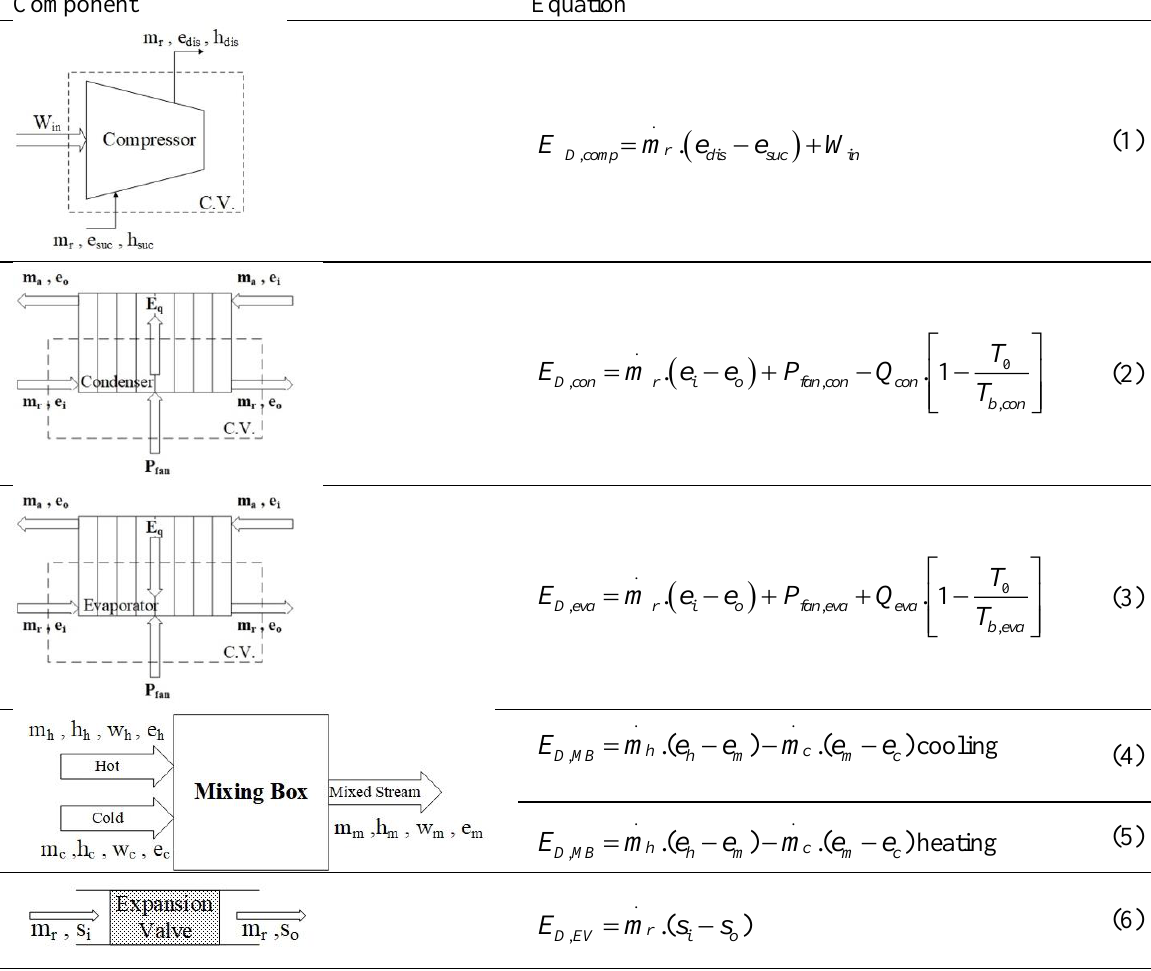
Table 1. Exergy destruction equations within each component of the system (Dincer & Rosen, 2015; Frangopoulos, 2009; Sayadi et al., 2019)